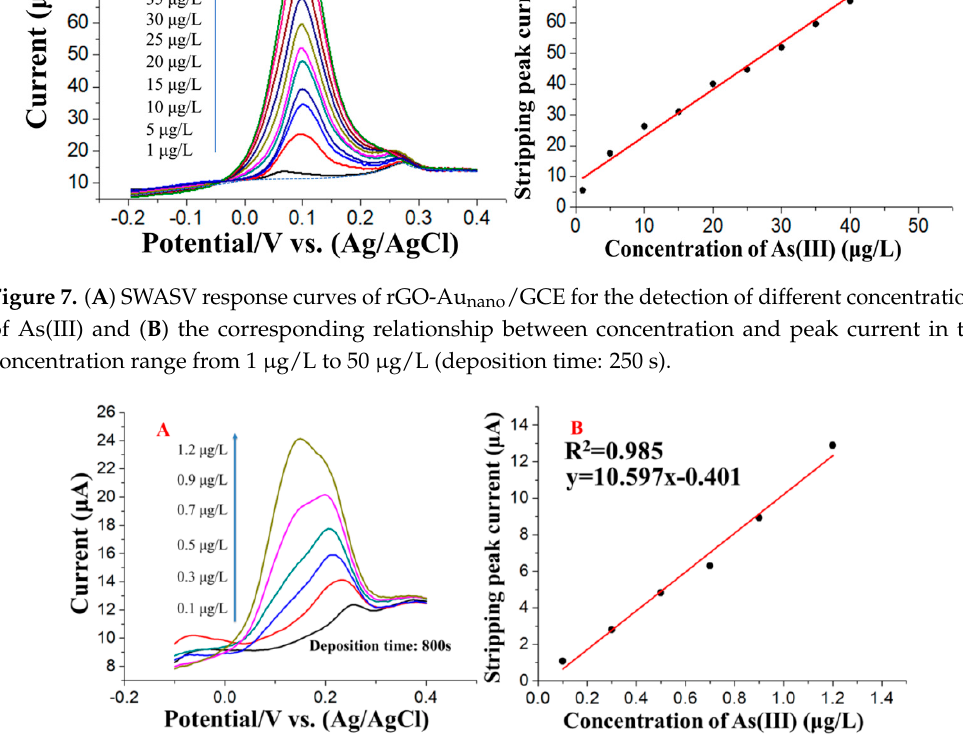
Figure 8. ( A ) SWASV response curves of rGO-Au nano /GCE for the detection of different concentrations of As(III) and ( B ) the corresponding relationship between concentration and peak current in a concentration range from 0.1 µ g/L to 1.2 µ g/L (deposition time: 800 s). Table 1. Comparison of different modified electrodes for the determination of As(III). Linear Range Electrodes Technique ( µ